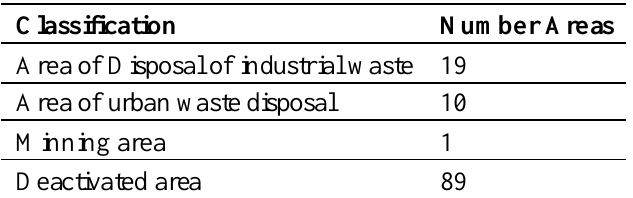
Table 1. Summary of registered areas, May